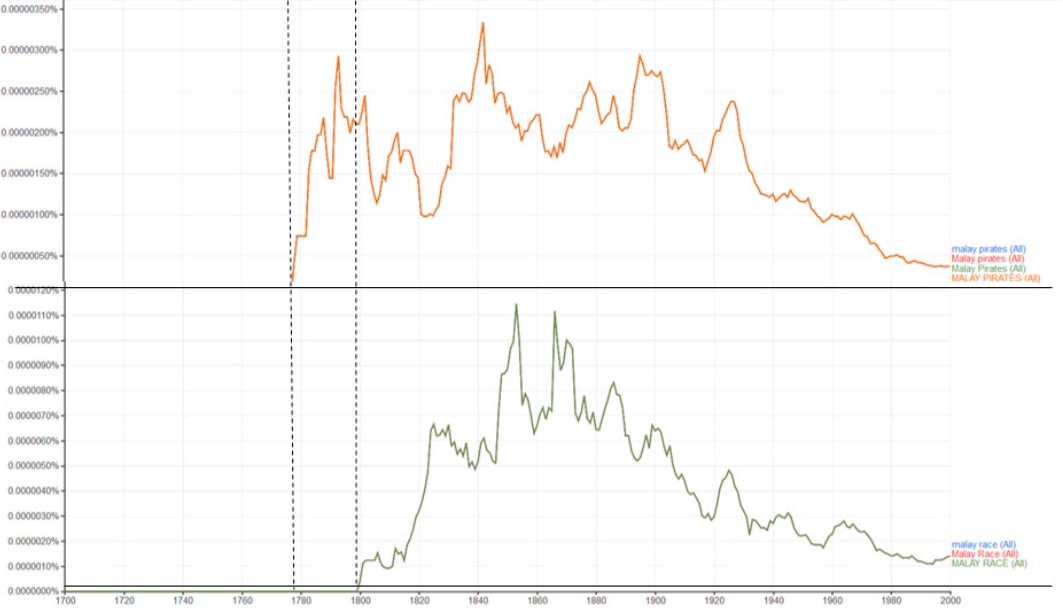
Figure 2. Google Ngram searches on the phrases “Malay pirates” and “Malay race”, respectively. The phrase “Malay pirates” appears in the corpus in the 1780s, whereas the term “Malay race” only appears after the turn of the nineteenth century. Source: Google Ngram search, 20 October